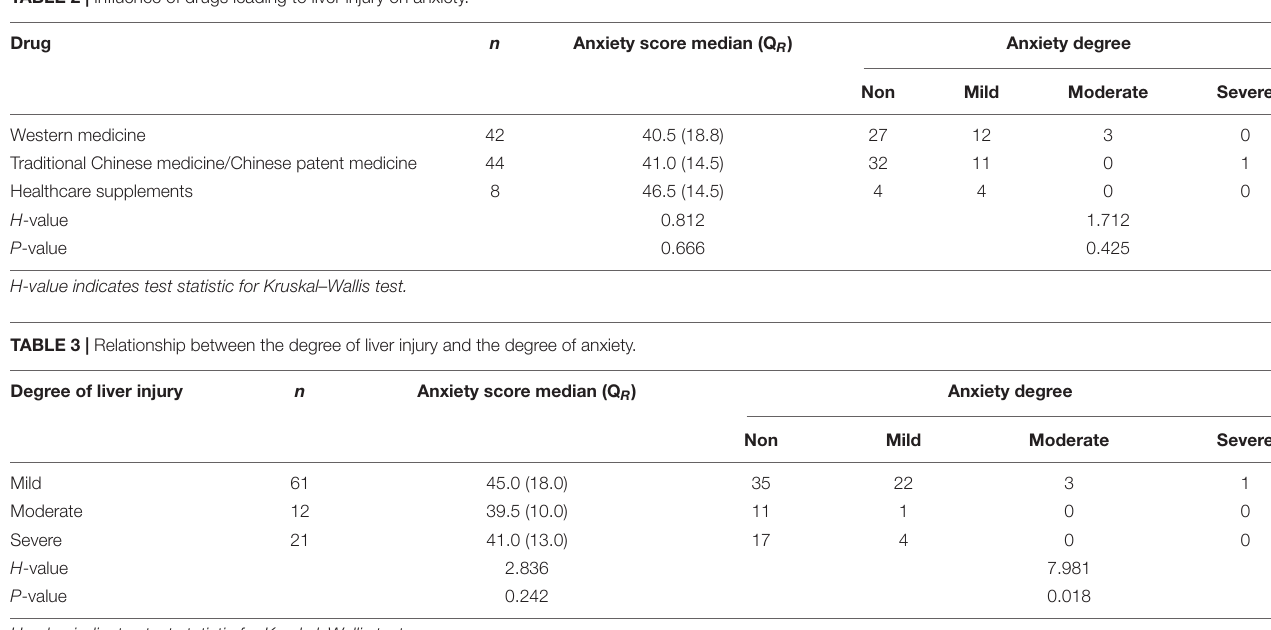
TABLE 2 | Influence of drugs leading to liver injury on anxiety.